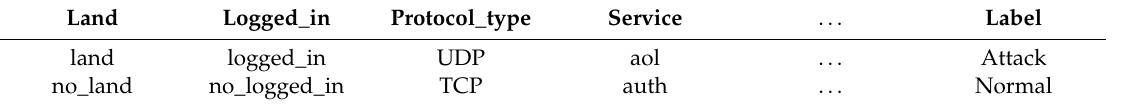
Table 1. The results of data preprocessing of the Apriori association algorithm.